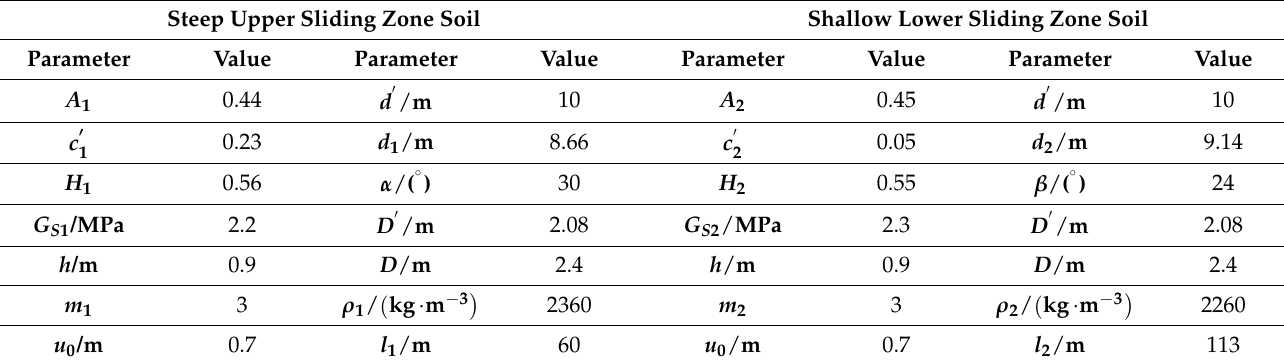
Table 1. Parameter values for the slope stability calculation